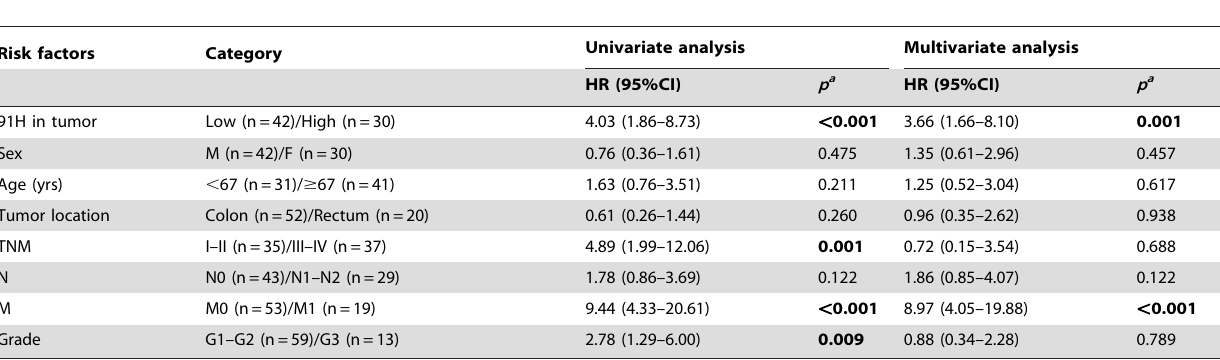
Table 2. Cox proportional hazard analysis: impact of 91H expression and clinicopathological parameters on overall survival in CRC patients.